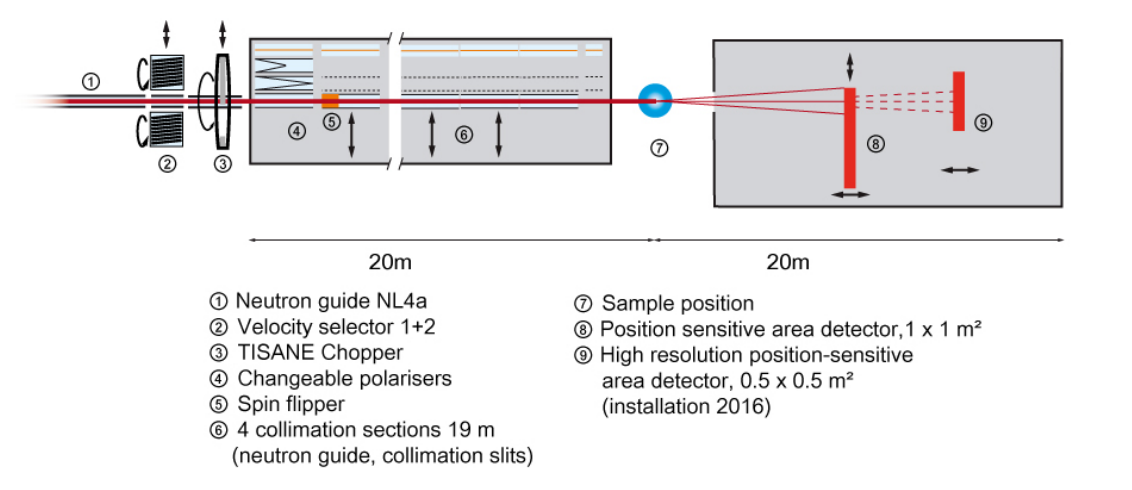
Figure 2: Schematic drawing of